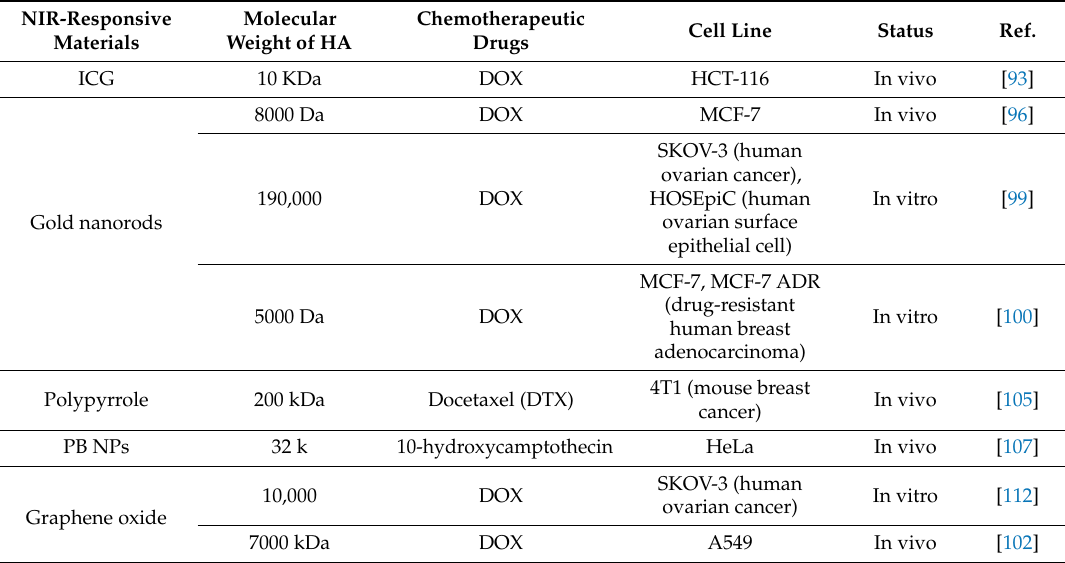
Table 2. HA-modified nanoplatforms for photothermal